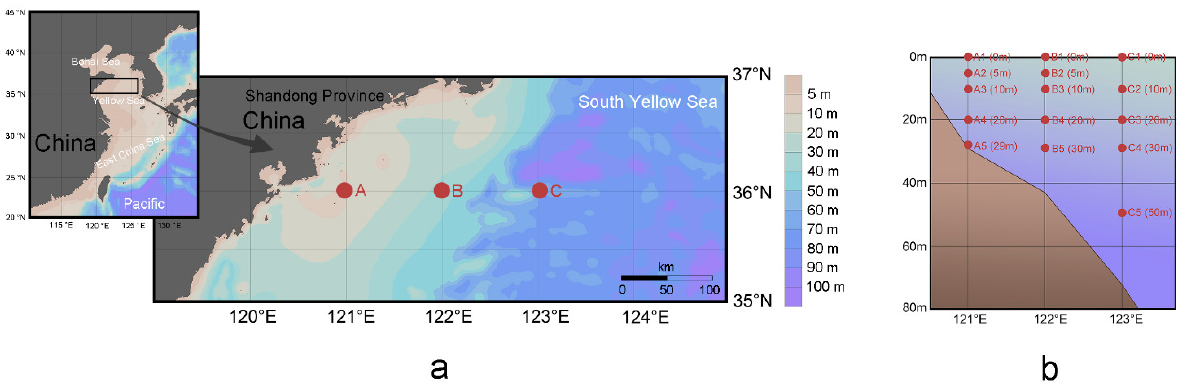
Figure 1. Geographic ( a ) and vertical position with depth in the parentheses ( b ) of all samples in the coastal South Yellow Sea; backgrounds were visualized using Ocean Data View v.5.1.7.